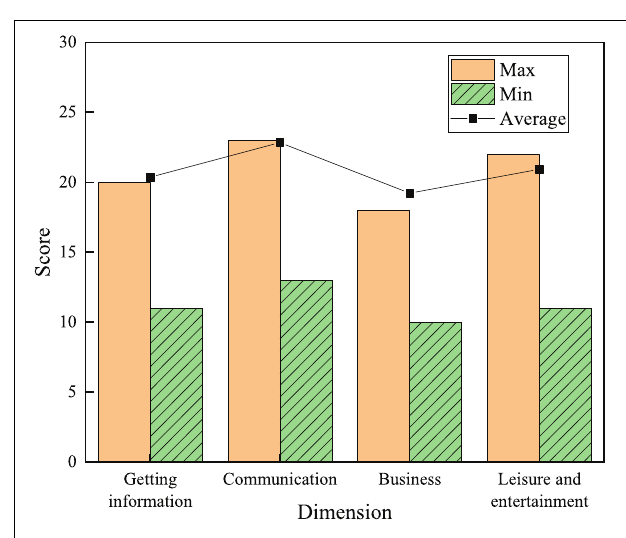
FIGURE 7 | Scores of behavioral